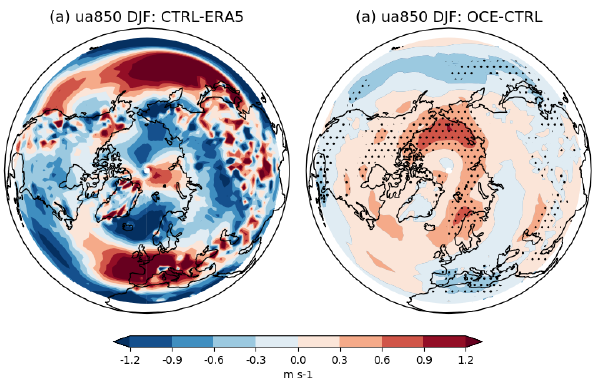
Figure B1. Mean zonal winds at 850hPa (ua850) over the DJF sea- son. In (a) CTRL minus ERA5, and (b) OCE minus CTRL. Stip- pling highlights grid points where the change is statistically signif- icant ( p < 0 . 05); in (a) most points outside the zero contour are significant, so stippling is not included for visual ease. The period covered is 1980–2015.